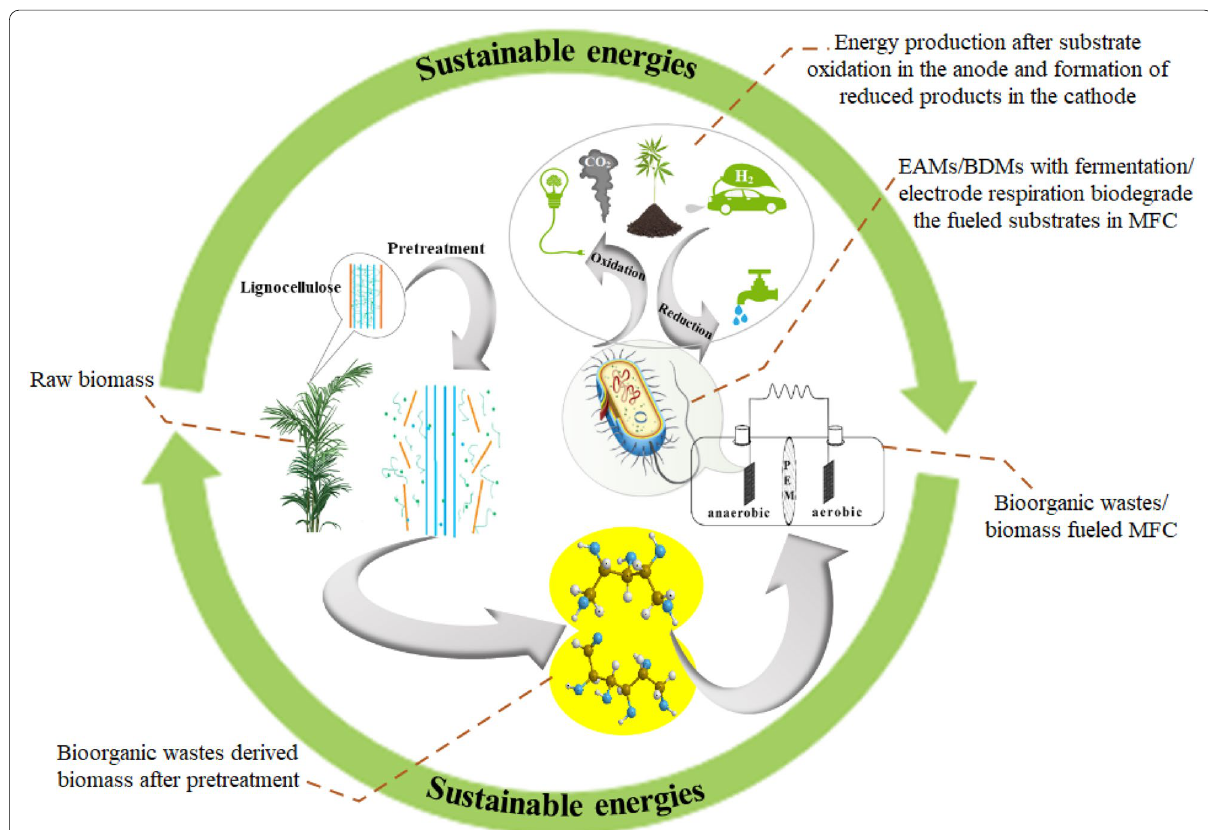
Fig. 2 Overview of processes for energy production from biomass in MFC. Pretreatment technique could break down the lignocelluloses to reducing sugars, which served the fuels for energy production by